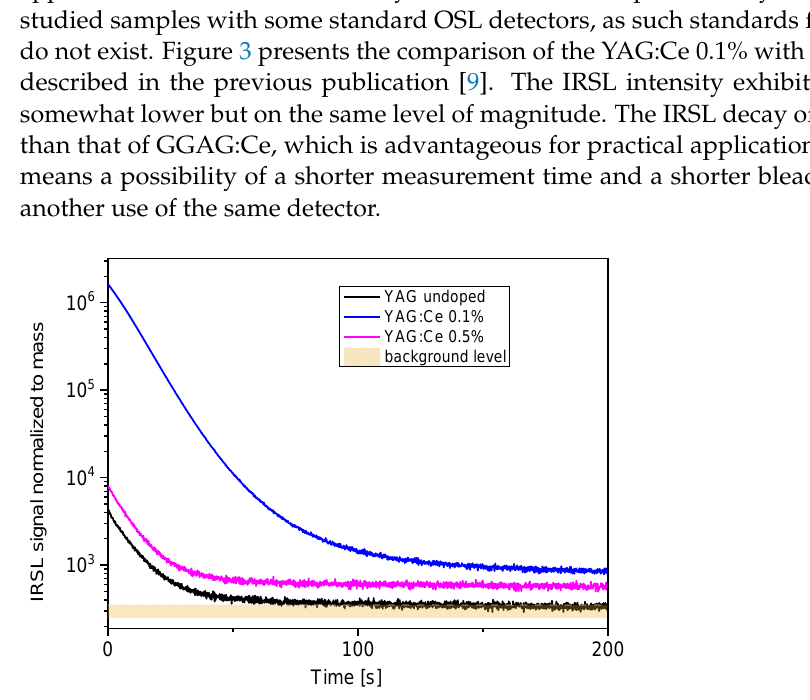
Figure 2. IRSL decay-curves of the studies YAG:Ce crystals. The wider band, corresponding to the background level, illustrates the variation range of the background. Dose 2 Gy.